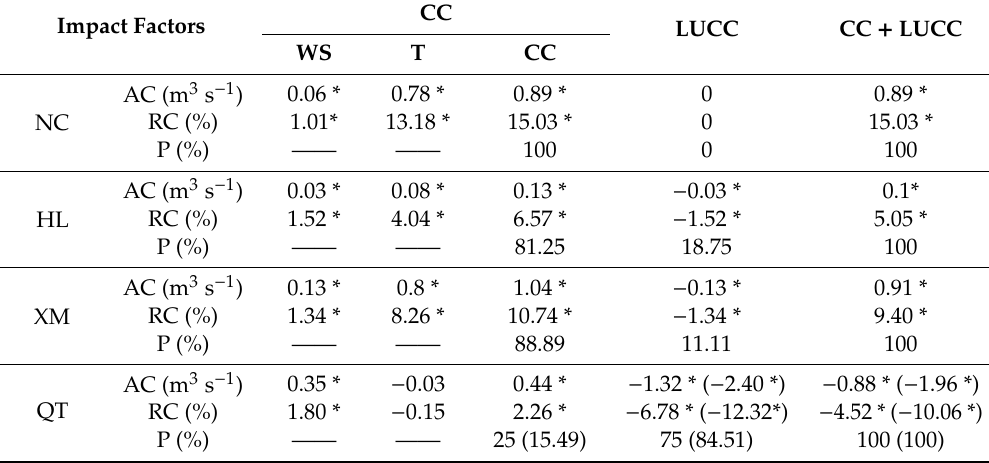
Table 8. Total and deconvolved impacts of temperature, wind speed, climate change, and land use / cover change on mean annual streamflow with reference to